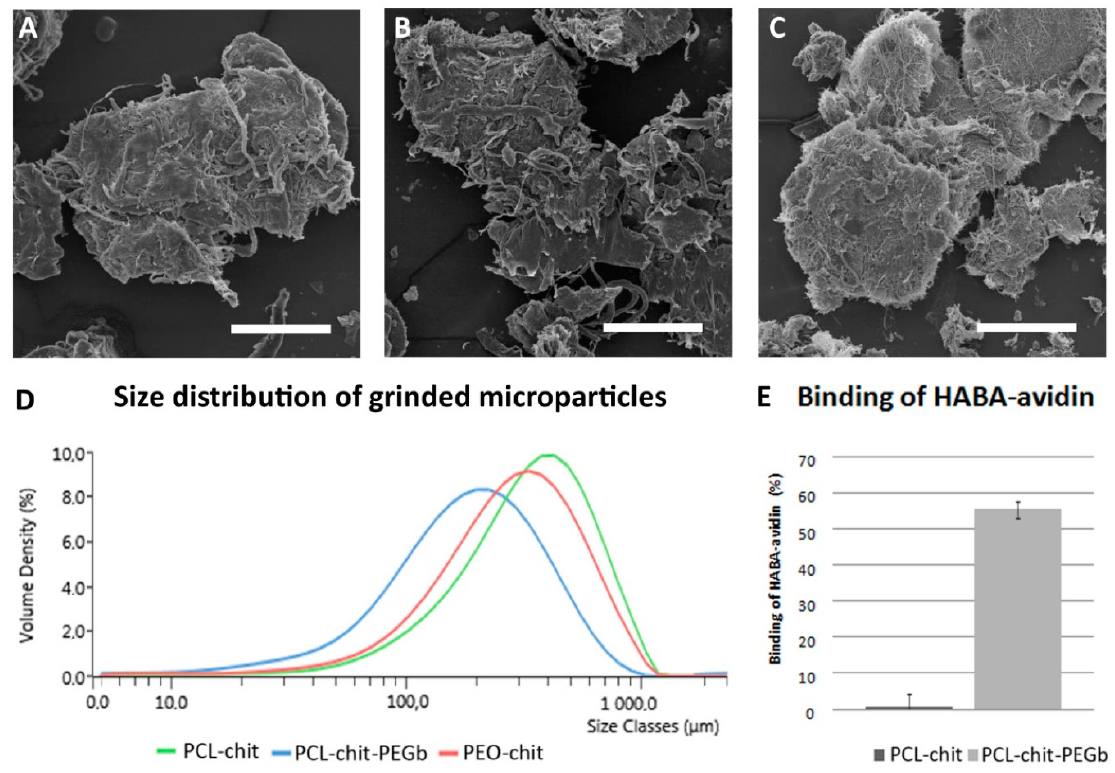
Figure 4. Morphology of grinded particles by SEM, PCL-chit ( A ), PCL-chit-PEGb ( B ) and PEO-chit ( C ). Distribution of microparticles (MPs) by DLS ( D ). Binding of the 4 (cid:48) -hydroxyazobenzene-2-carboxylic acid (HABA)–avidin complex to chitosan and to chit-PEGb ( E ). Scale bar: 100 µ